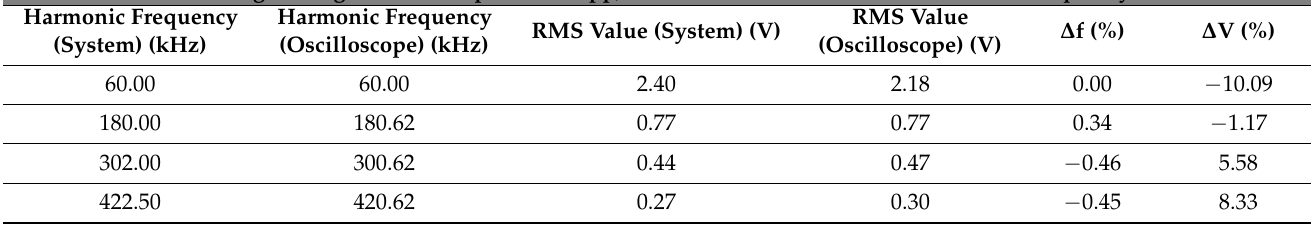
Table 5. Comparisons between the calibrated oscilloscope and the FPGA-based system measurements for rectangular signal with amplitude of 5 Vpp with 2.5 VDC offset value, for a signal’s fundamental frequency at 60